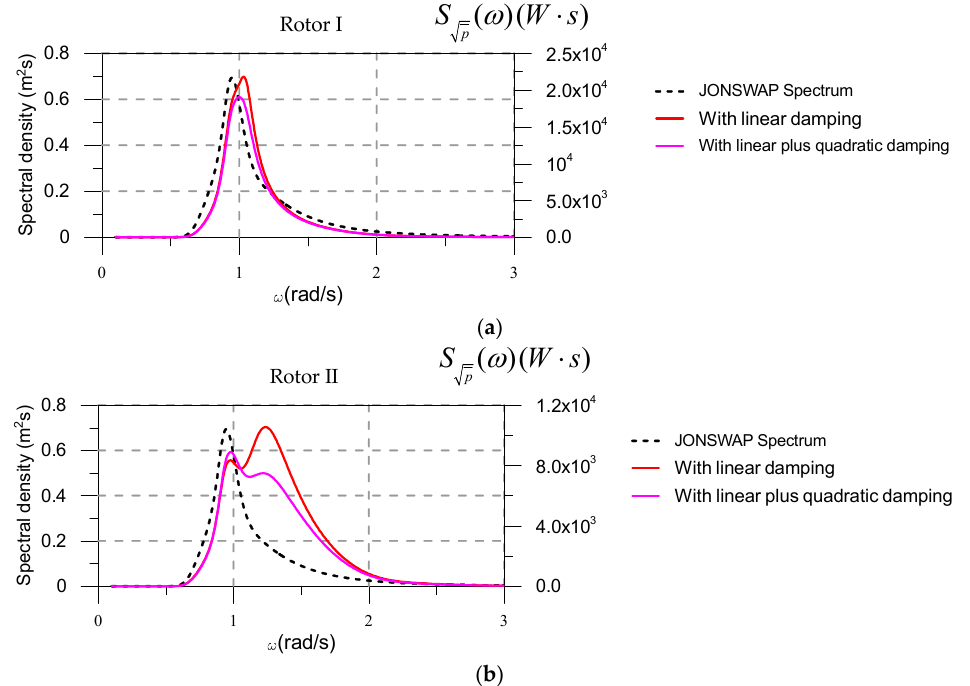
Figure 11. ( a ) Rotor I ( b ) Rotor II; Spectrum; and the square-root of power spectral response of the different rotors as a function of wave frequency.